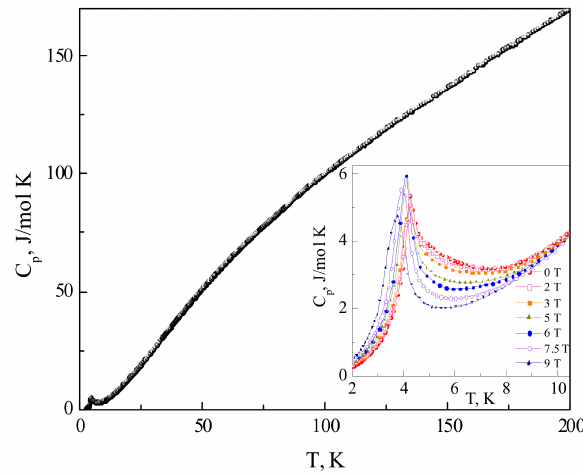
Figure 4. Temperature dependence of specific heat C p in PbCu(SeO 4 )(OH) 2 . Inset: C p ( T ) curves taken at various magnetic fields.